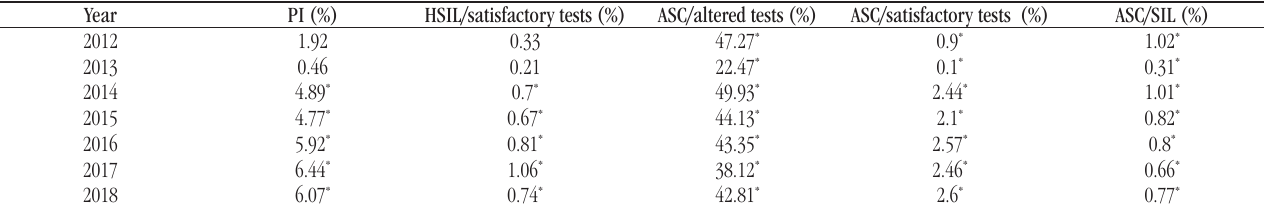
table 3 – Internal quality monitoring indicators of the of cervical cytopathological exams underwent by the female population using SUS, in the municipality of Cascavel, Paraná, between 2012 and 2018 Year PI (%) HSIL/satisfactory tests (%) ASC/altered tests (%) ASC/satisfactory tests (%)